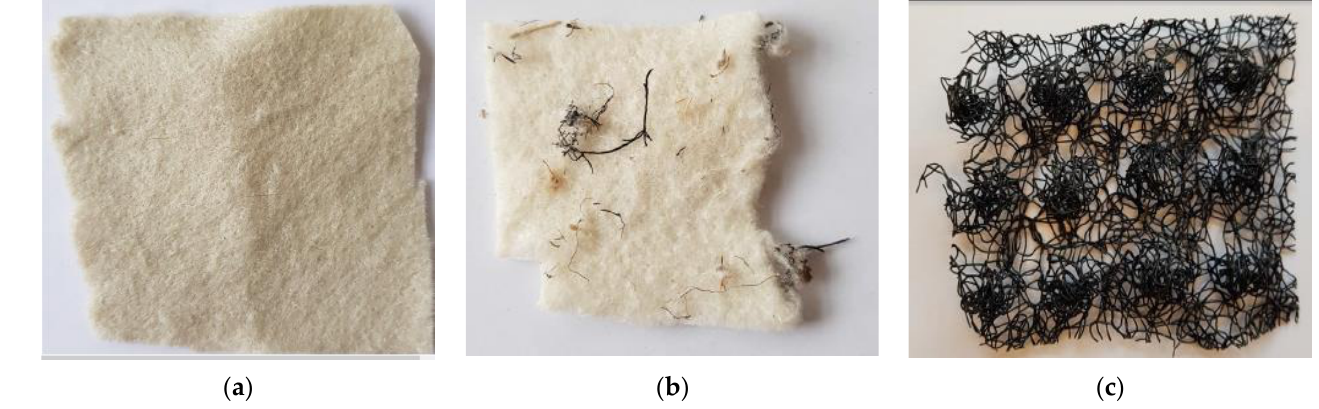
Figure 8. Analysed samples: ( a ) virgin geotextile Dornit ECO 300, ( b ) naturally aged geotextile sampled (sample Ryb01) after several months of exposure under natural conditions, and ( c ) virgin erosion control geomat.